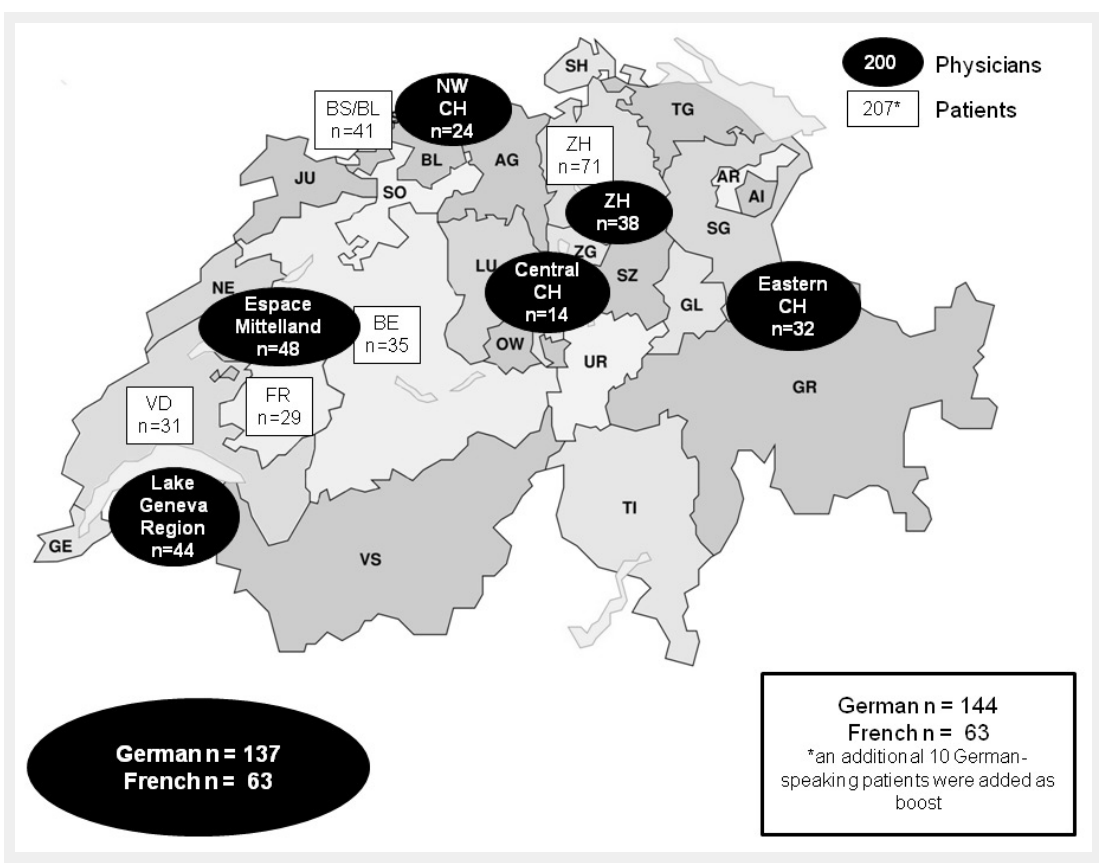
Figure 2 Regional distribution of study participants. Dark oval fields represent the physicians. White rectangular fields represent the patients. Abbreviations on the map represent the different cantons of Switzerland. Patients were recruited from Bern (BE), the Basel area (BS/BL), Fribourg (FR), Vaud (VD) and Zurich